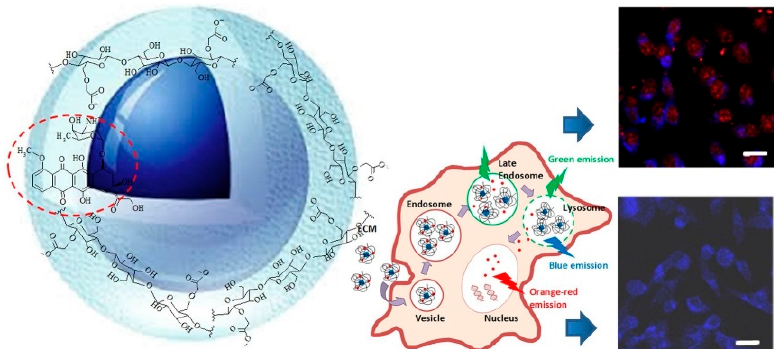
Figure 3. Representation of multifunctional nanovehicles for GMB theranostics based on a supramolecular colloid complex ZnS@CMC combined with DOX. Reproduced with permission from [31]. Elsevier (2019).